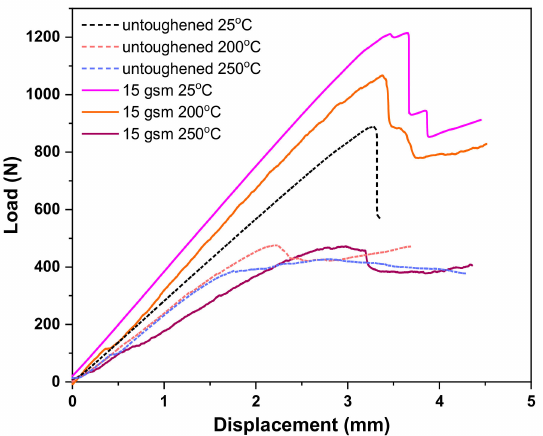
Figure 11. Load–displacement curves in ENF tests of untoughened and 15 gsm fiber veils interleaved laminates measured at different